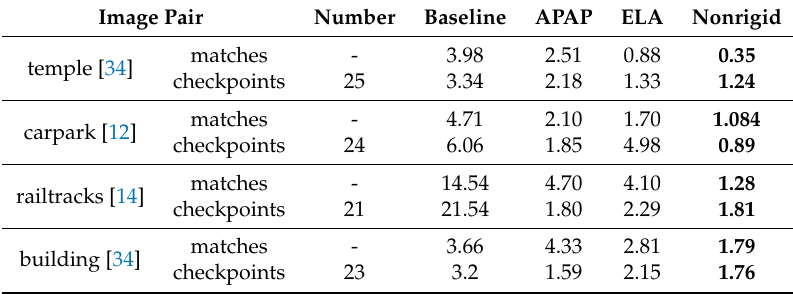
Table 1. Comparison of average root mean squared error RMSE for the proposed method and other methods.